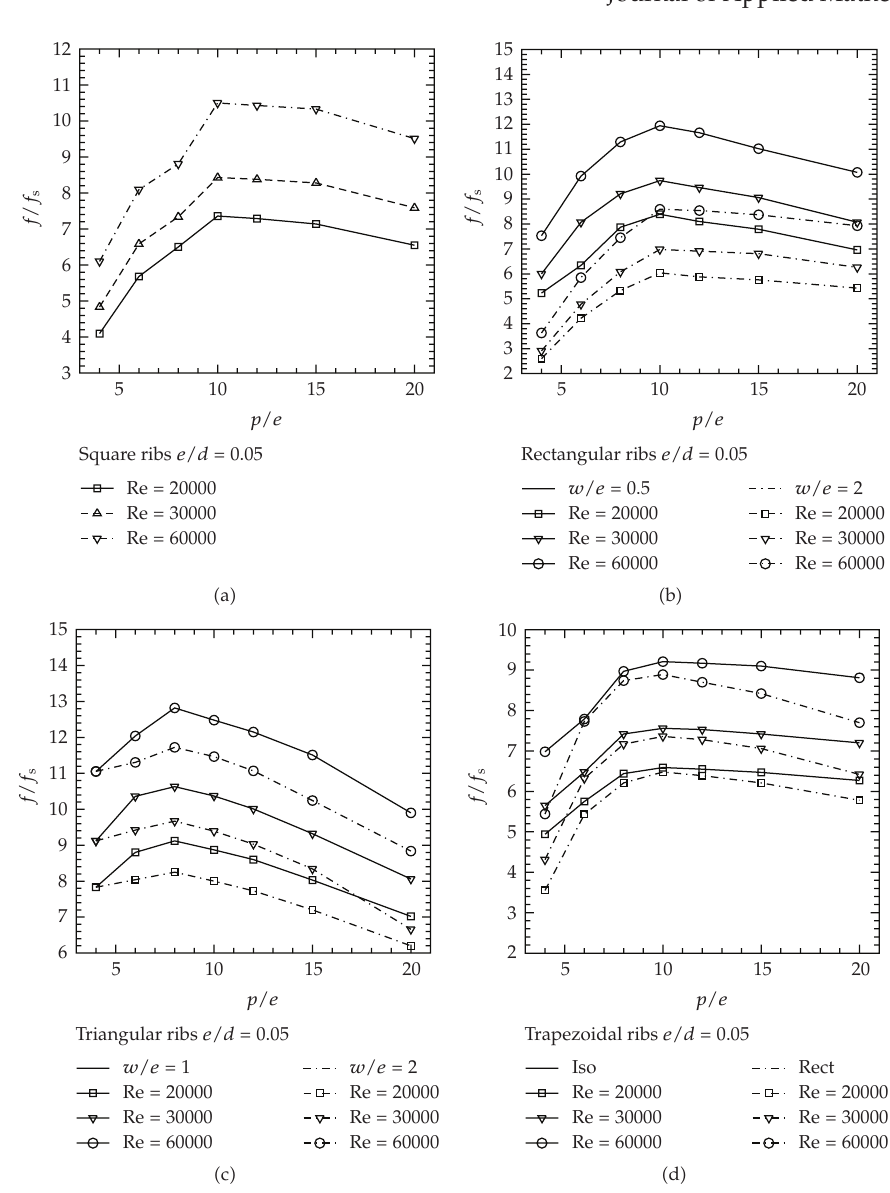
Figure 6: Friction factor profiles, referred to the smooth channel results, as a function of p/e at Re (cid:8) 20000, 30000, and 60000, for e/d (cid:8) 0 . 05: (cid:6) a (cid:7) square-ribs, (cid:6) b (cid:7) rectangular ribs with w/e (cid:8) 0 . 5 and 2.0, (cid:6) c (cid:7) triangular ribs with w/e (cid:8) 1 . 0 and 2.0, and (cid:6) d (cid:7) isosceles and rectangular trapezoidal ribs with w/e (cid:8) 2 .